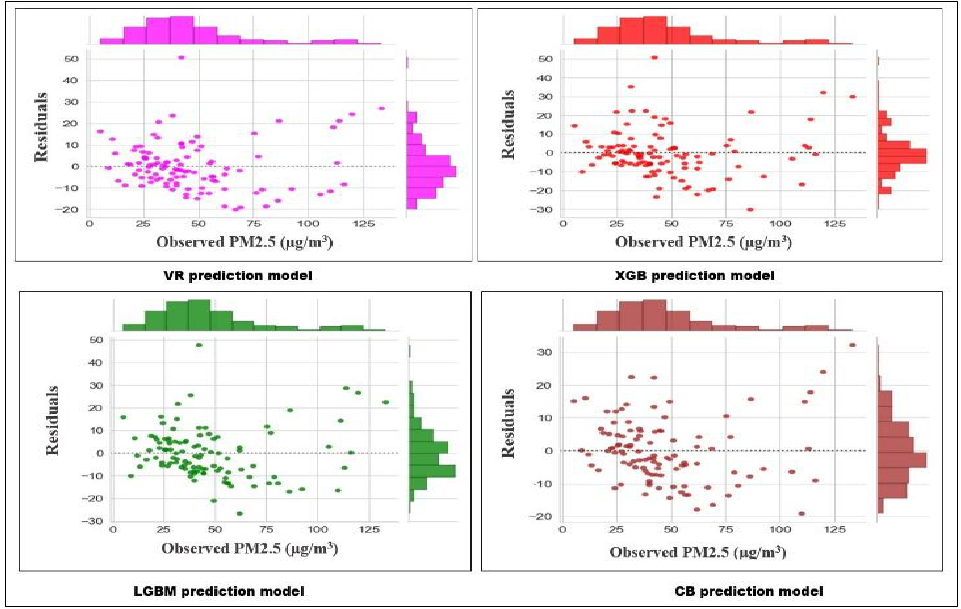
Figure 5. Residual plots of test dataset using VR, XGB, LGBM and CB prediction models.